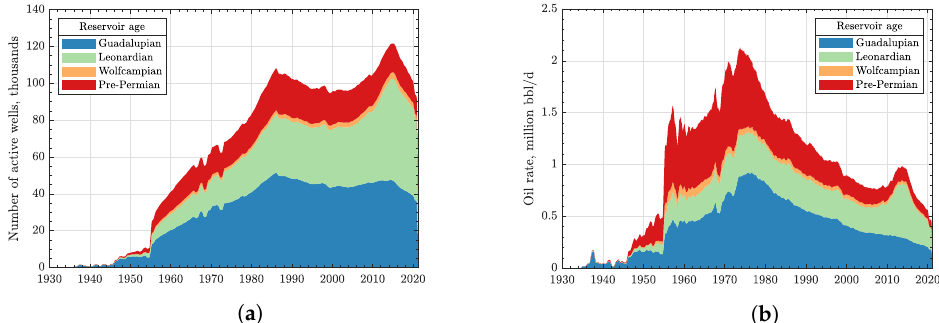
Figure 6. ( a ) Number of active wells and ( b ) total field–daily oil rate colored by reservoir age. Table 1. Summary of four reservoir ages and list of reservoir names included. The cross-ticked boxes indicate the existence of each reservoir layer in six different areas